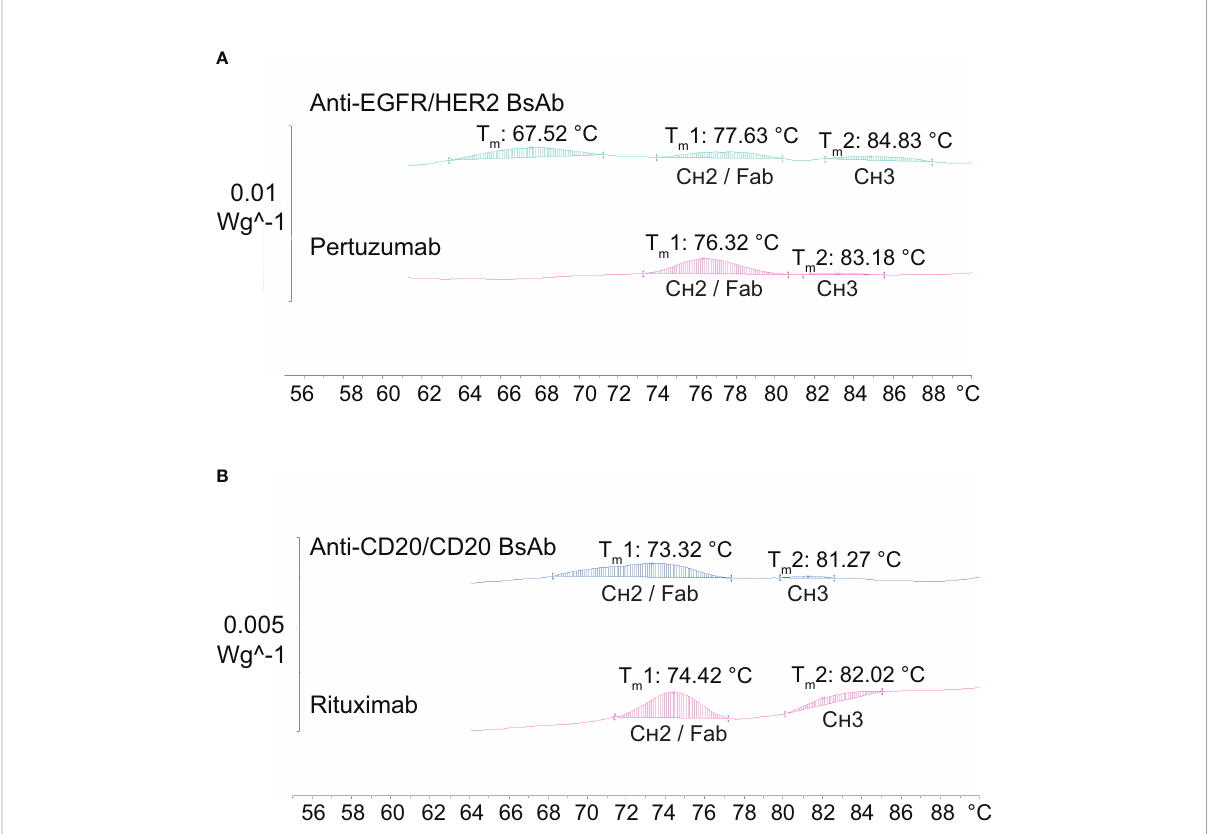
FIGURE 7 Thermal stability analysis of antibodies by differential scanning calorimetry (DSC). (A) The anti-EGFR/HER2 BsAb together with its parental mAb (pertuzumab) show two peaks of similar T m values corresponding to the C H 2/Fab and C H 3 domains, with an extra peak at T m 67.52°C. (B) The anti-CD20/CD20 BsAb exhibits similar T m values for the C H 2/Fab and C H 3 domains when compared to its parental mAb